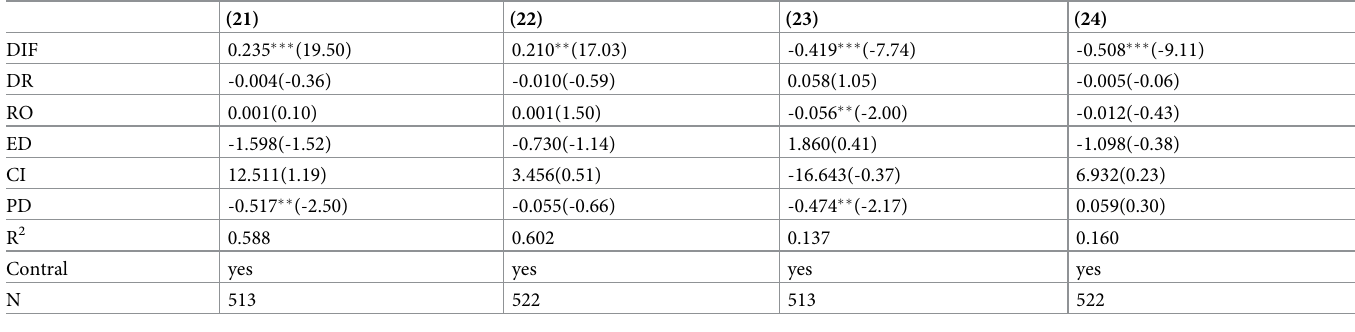
Table 8. Income level